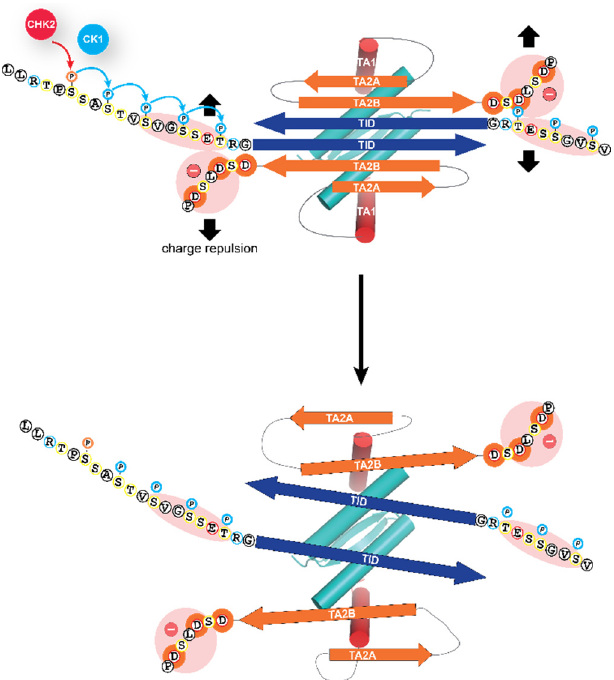
Figure 3. Molecular mechanism of the activation process. The closed dimeric state of TAp63 α is stabilized by the formation of a six-stranded antiparallel β -sheet, formed by the C-terminal TI domain and two segments close to the N-terminal transactivation domain, TA2A and TA2B. This β -sheet blocks the tetramerization interface of the oligomerization domain. The addition of the phosphate groups by the kinase CK1 results in electrostatic repulsion with a negatively charged cluster of aspartic acid residues leading to the opening of the closed dimeric state. The segment labeled TA1 forms a helix that in the closed conformation occupies the same site on the oligomerization domain as the second helix of the oligomerization domain in the full tetrameric state [62,64,76]. Only the TA1 peptide sequence acts in the activated state as a transactivation domain, while the two β -strand sequences TA2A and TA2B act as elements of the inhibitory mechanism, thus differing from the bi-partite transactivation domains of p53 and p73 [69].